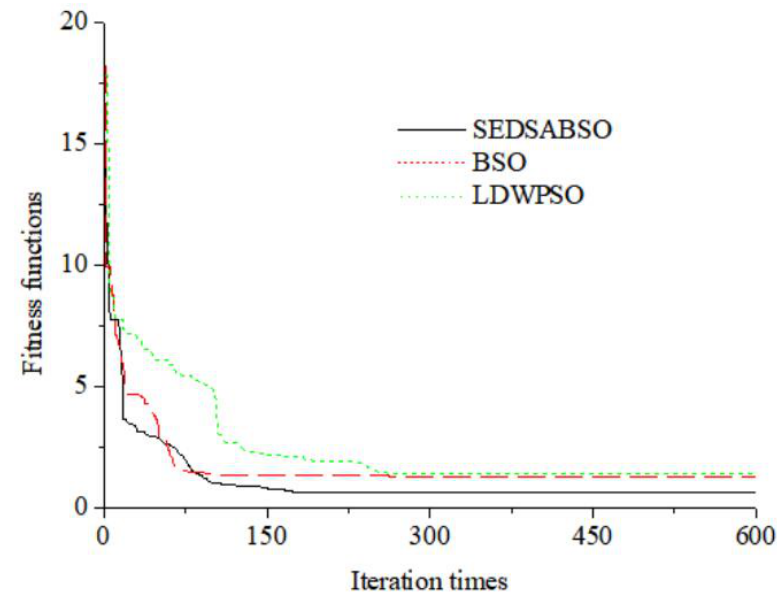
Figure 6. Iterative curve of the algorithm.